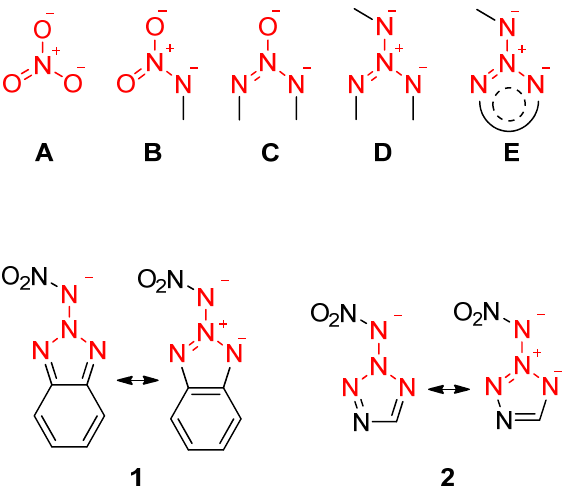
Figure 1. Nitrate anion A , related isoelectronic structures B – E , and E -type anions 1 and 2 .